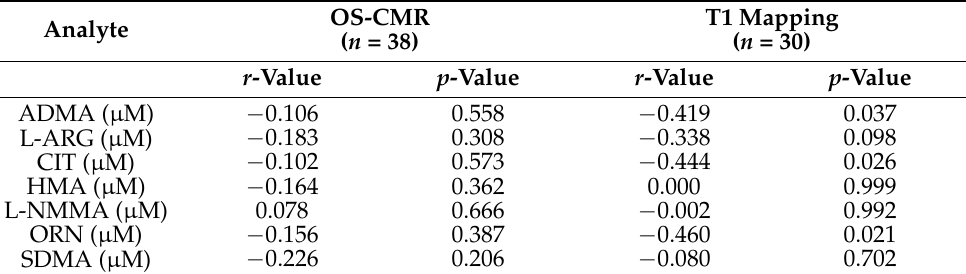
T1 Mapping ( n = 30)